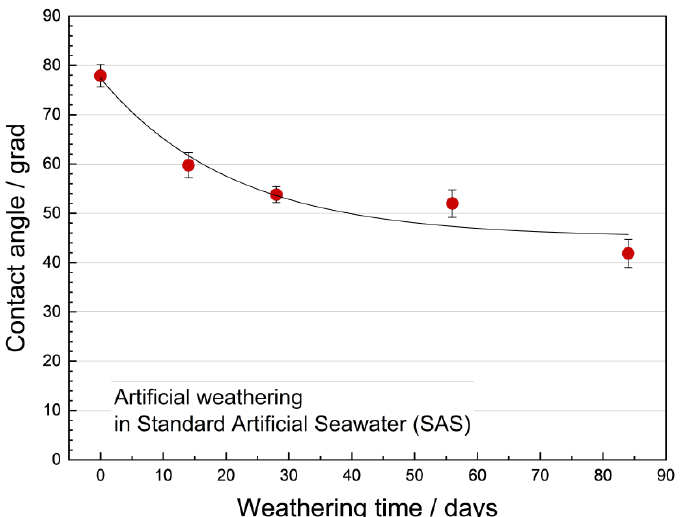
Figure 3. Temporal development of the contact angle of PET sheets artificially weathered under laboratory conditions in standard artificial seawater (SAS).